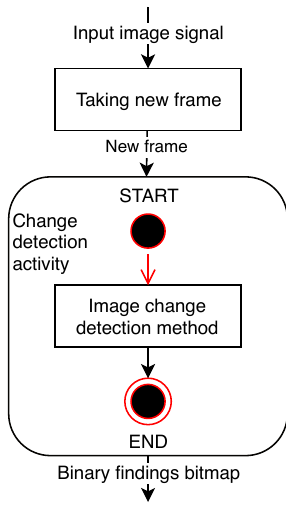
Figure 1. Diagram of frame change detection